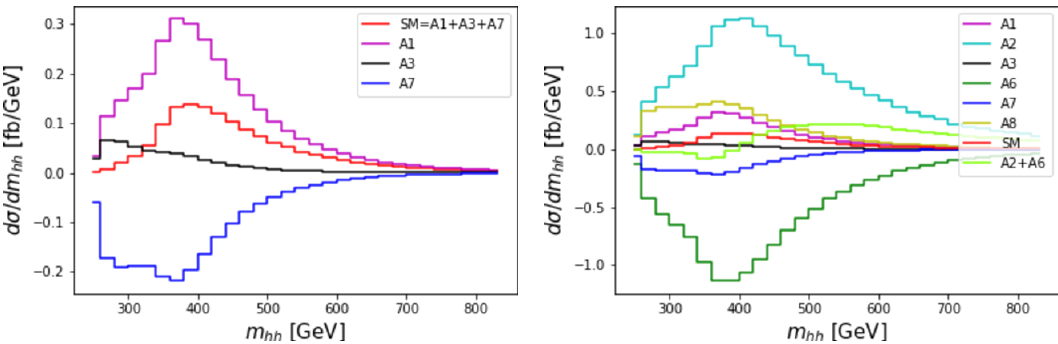
Figure 12 . Contributions of the coe(cid:14)cients A i in eq. (2.5) which are relevant for (cid:12)gure 11.